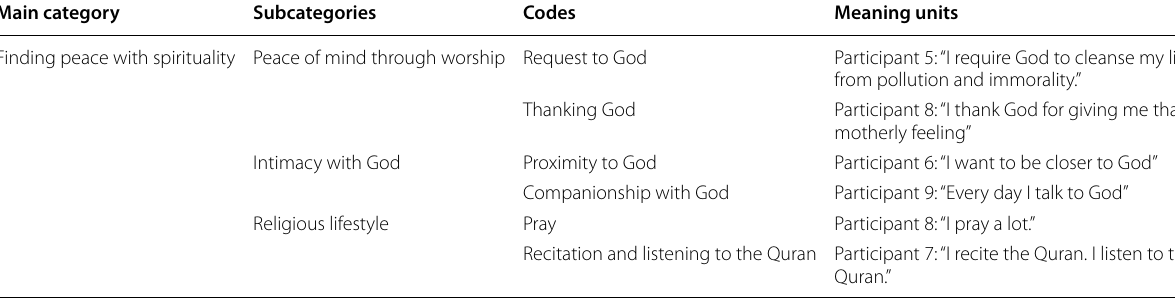
Table 1 Coding process Main